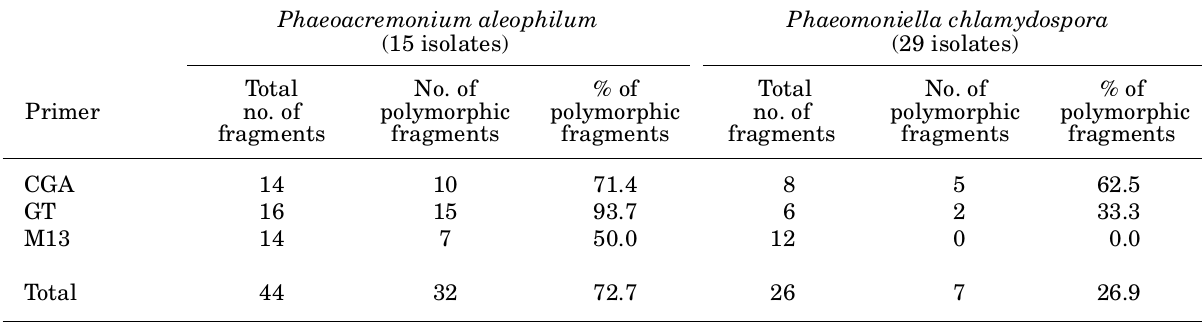
Table 3. Total number of fragments, and number and percentage of polymorphic fragments, as amplified by three